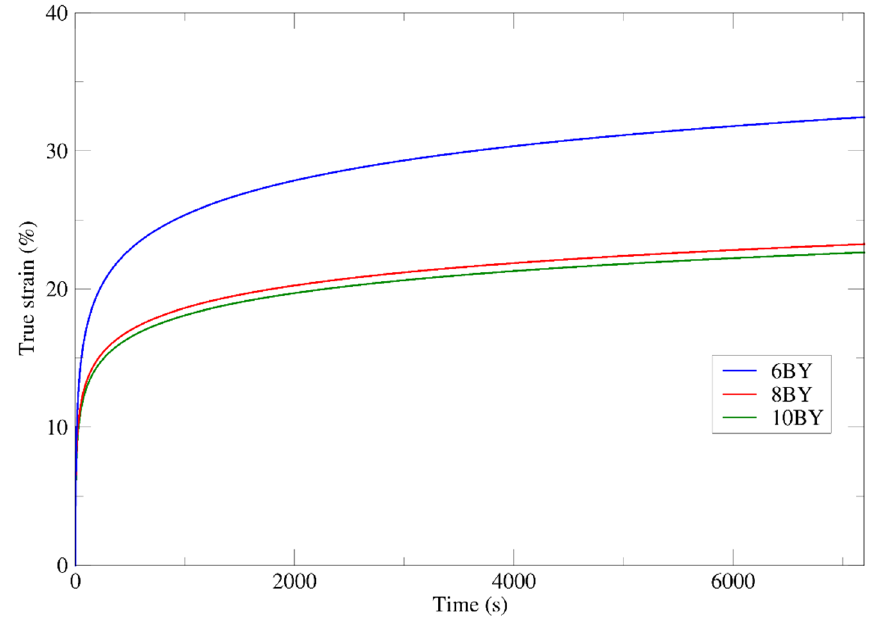
Figure 12. Mean curves of tensile creep tests of PVA 6BY, 8BY, and 10BY.